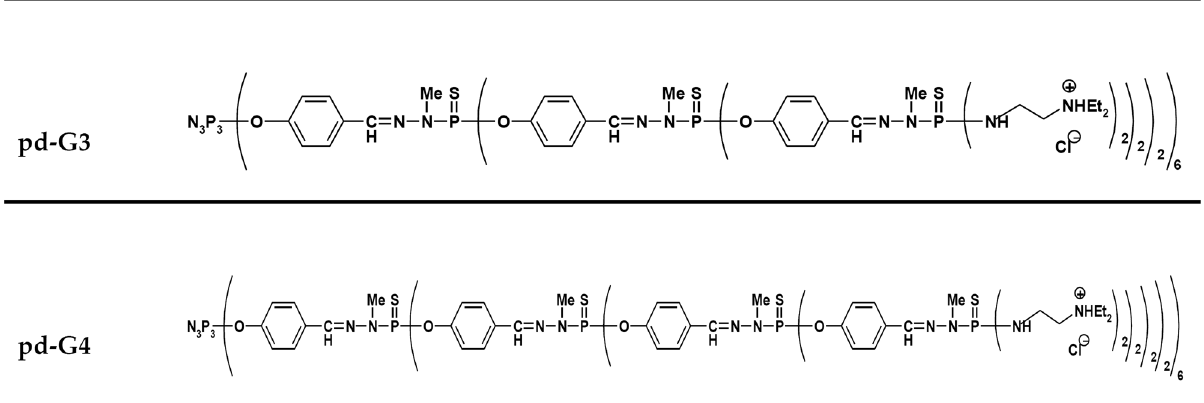
Figure 8. Structure of phosphorus-containing dendrimers of generations 3 and